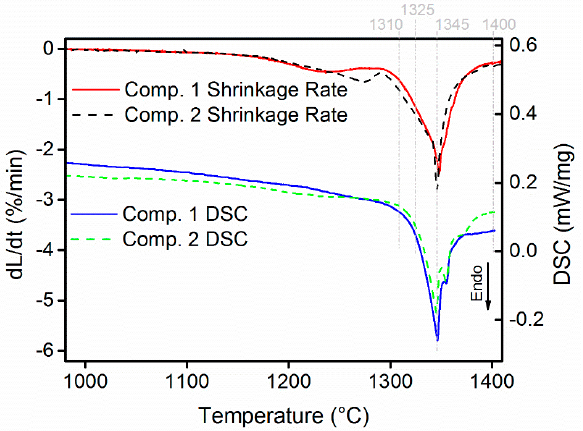
Figure 4. Shrinkage rates and differential scanning calorimetry (DSC) curves of composite 1 and 2. The temperatures indicated by gray dashed lines are selected for interrupted sintering.